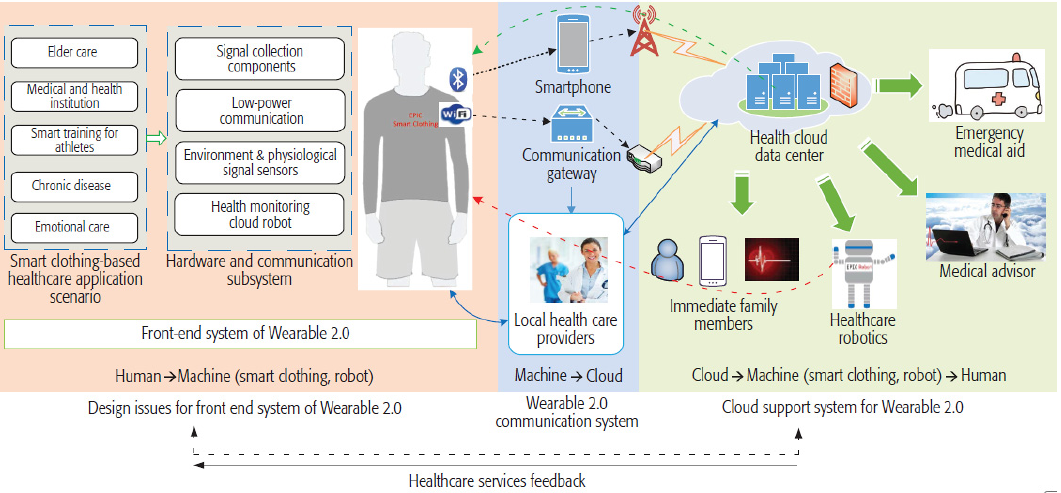
Figure 23. Design for a smart clothing-based healthcare system [72] (Reprinted with permission from ref. [72]. Copyright 2021 IEEE).